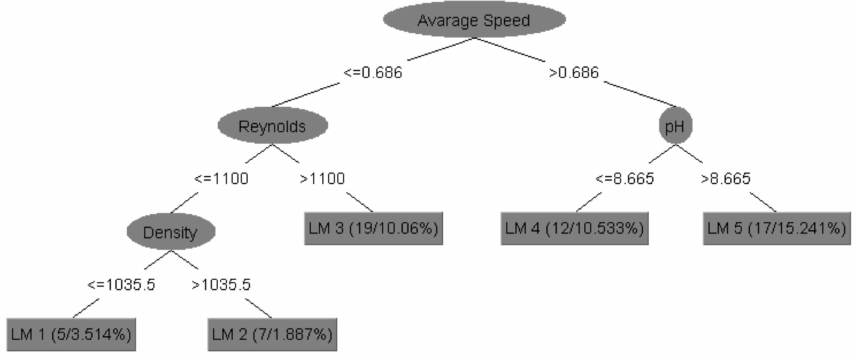
Figure 4. The tree structure.